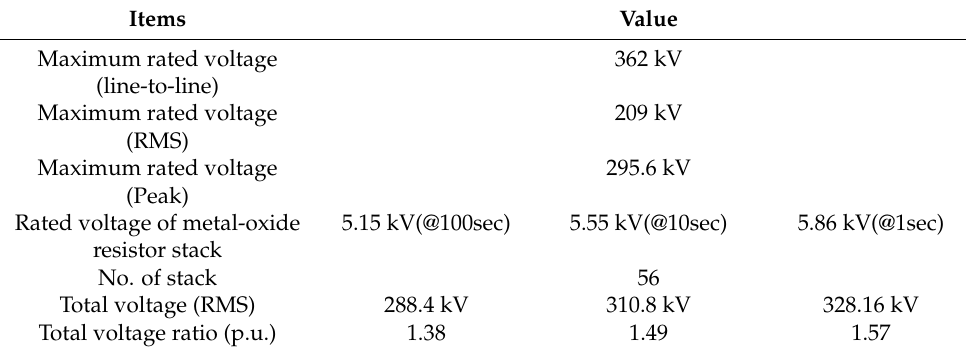
Table 4. Test result of withstand voltage of MOV resistor